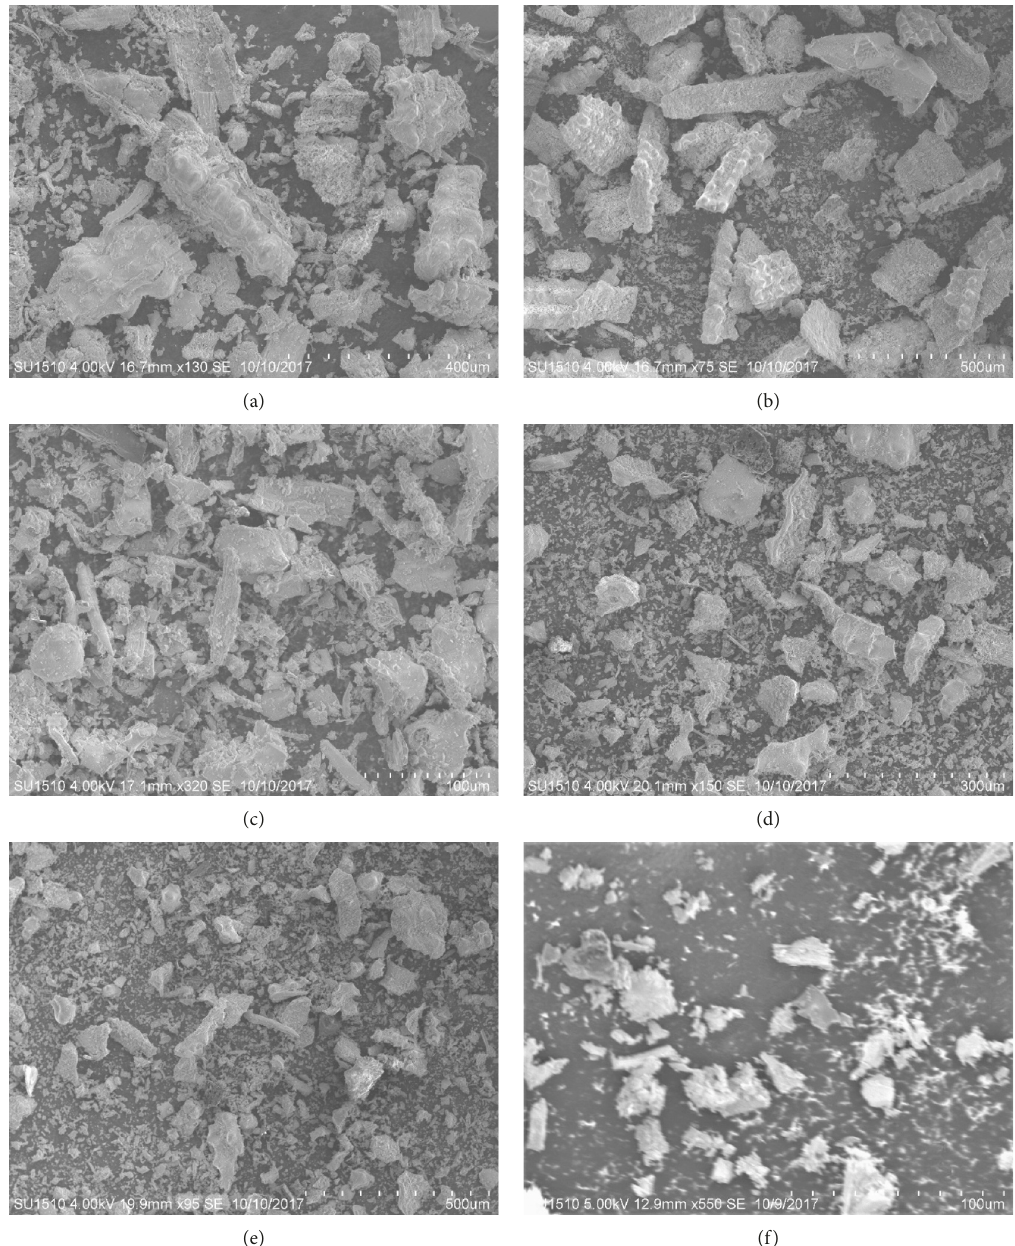
Figure 1: SEM photograph of RHA: (a) natural RHA, (b) at 60min of grinding, (c) at 90min of grinding (d) at 120min of grinding, (e) at 180min of grinding, and (f) RHA200 (RHA passing through No. 200